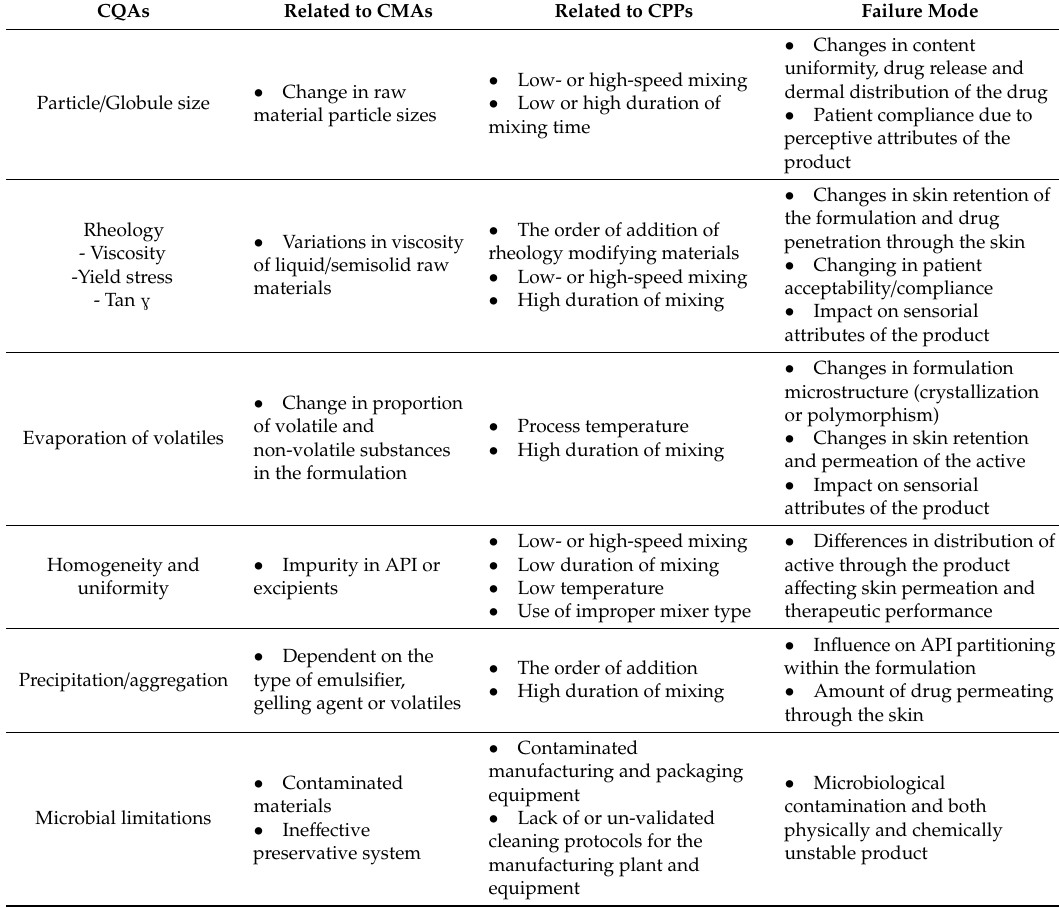
Table 2. The possible failure modes a ff ected by changing CMAs and